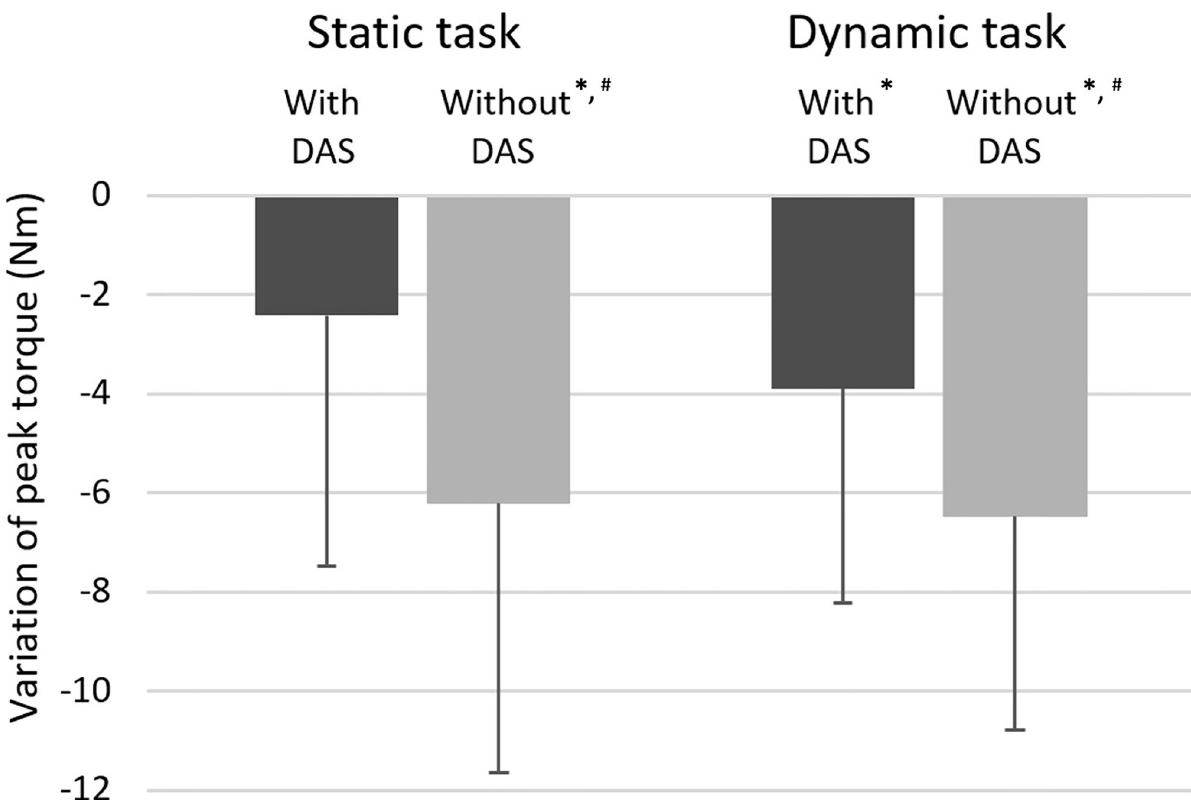
Fig 2. Mean variation in isometric peak torque (in newton-meters [Nm]); With standard deviation) in shoulder flexion after the tasks with and without the dynamic arm support (3D-DAS) when compared to baseline (n = 15 for each task). � Isometric peak torque significantly lower compared to baseline (p < 0.003) # Isometric peak torque significantly lower compared to when the task was performed with the 3D-DAS (p < 0.015).